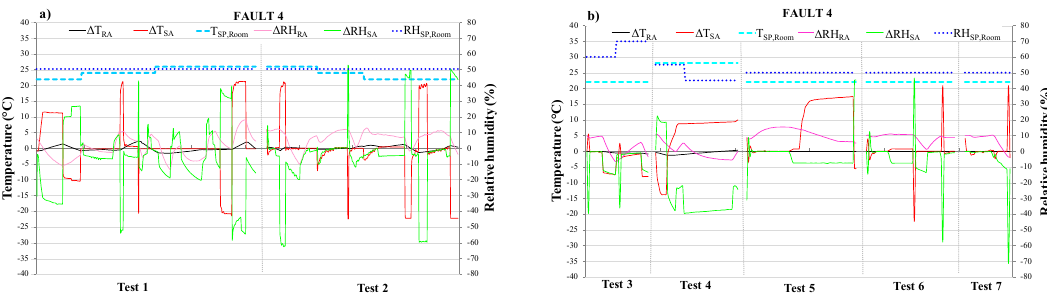
Figure 10. Comparison between normal operation and operation with fault 4: test 1, 2 ( a ), test 3, 4, 5, 6, 7 ( b ).